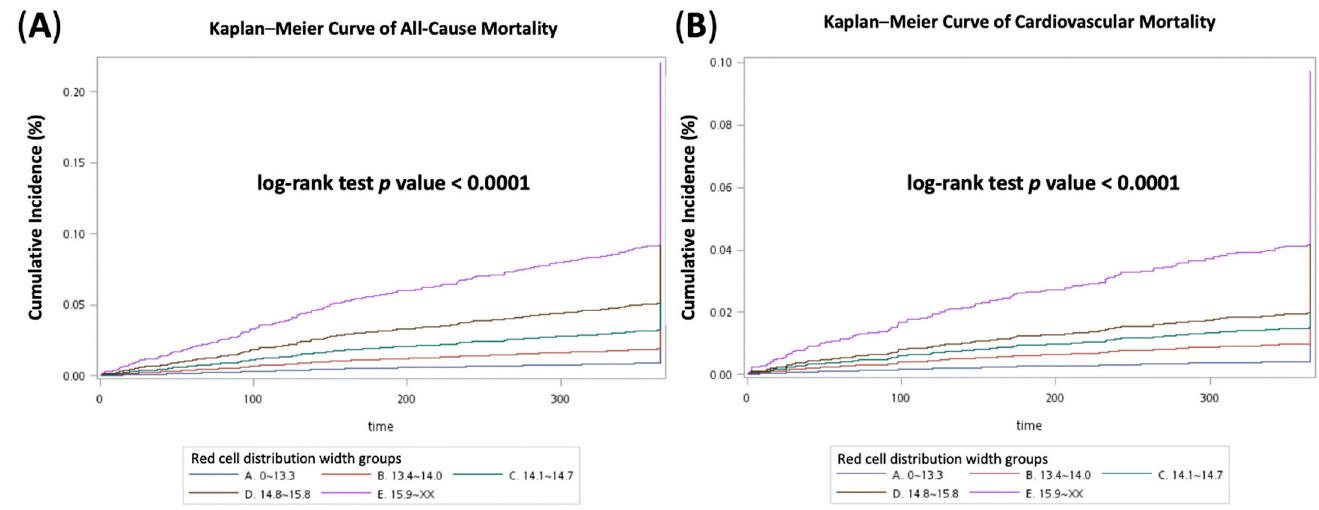
Figure 1. Kaplan–Meier curves of ( A ) 1-year all-cause mortality, and ( B ) 1-year cardiovascular mortality in all study patients.